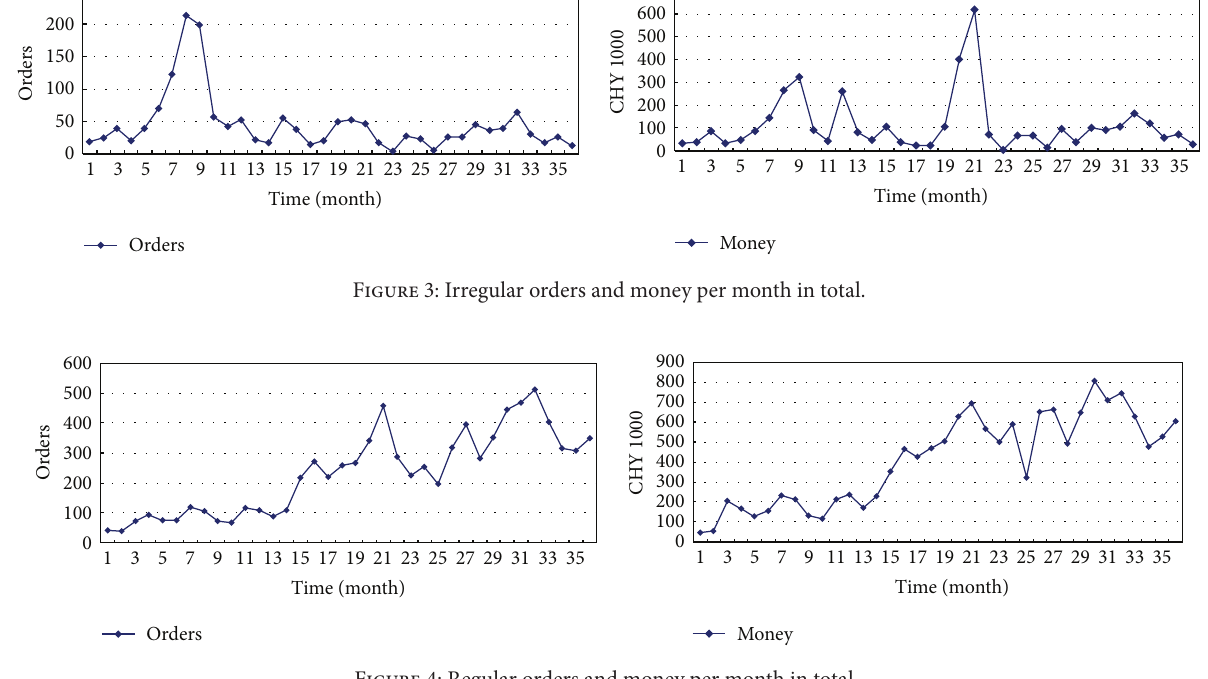
Figure 4: Regular orders and money per month in